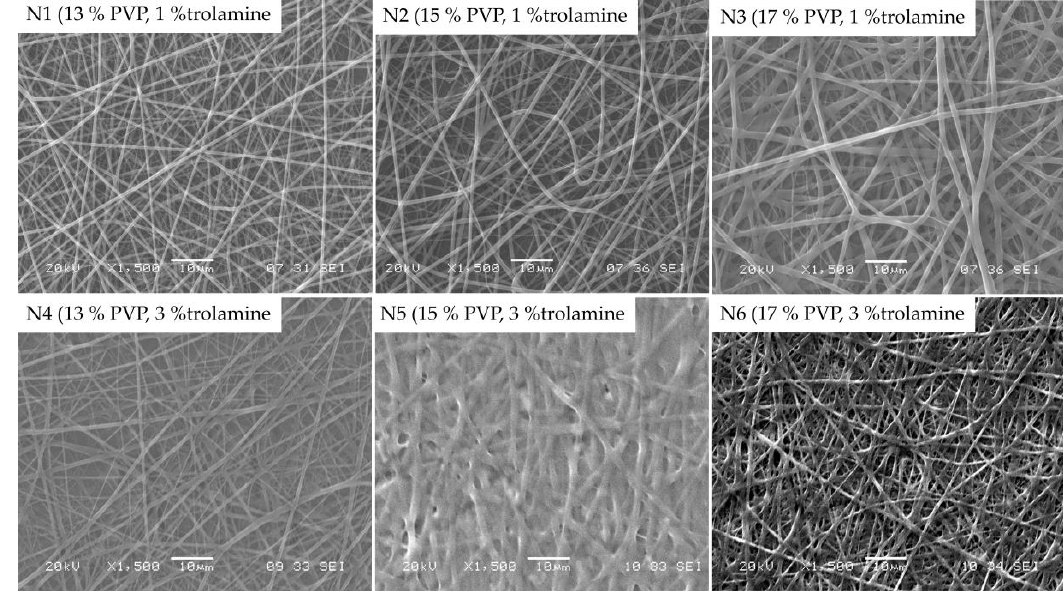
Figure 2. SEM morphology of different samples at 1500× magnification.